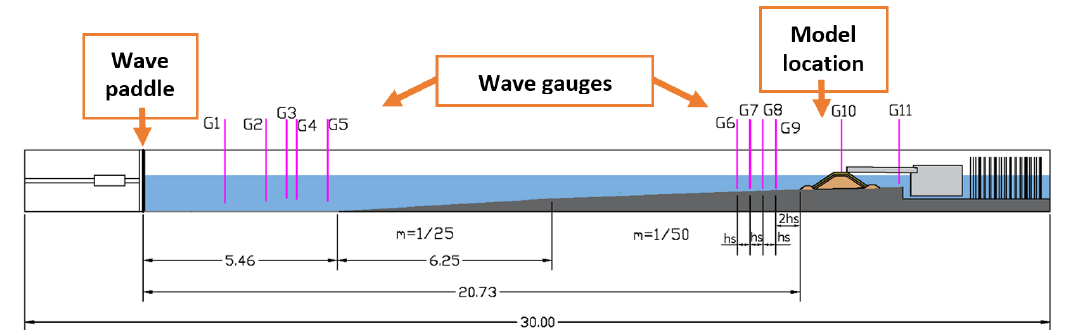
Figure 2. Longitudinal cross-section of the LPC-UPV wave flume (dimensions in meters).